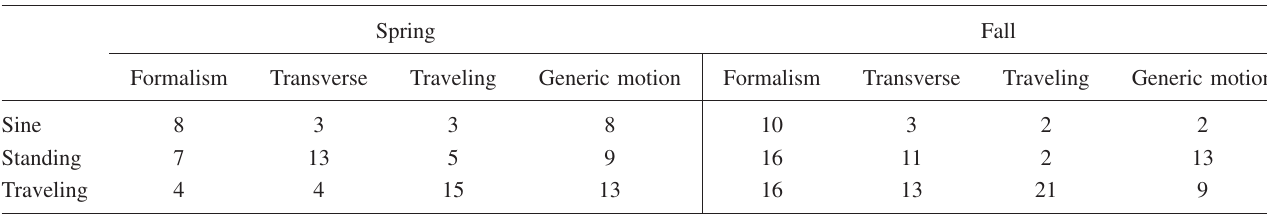
TABLE VI. Long answer reasons for string.